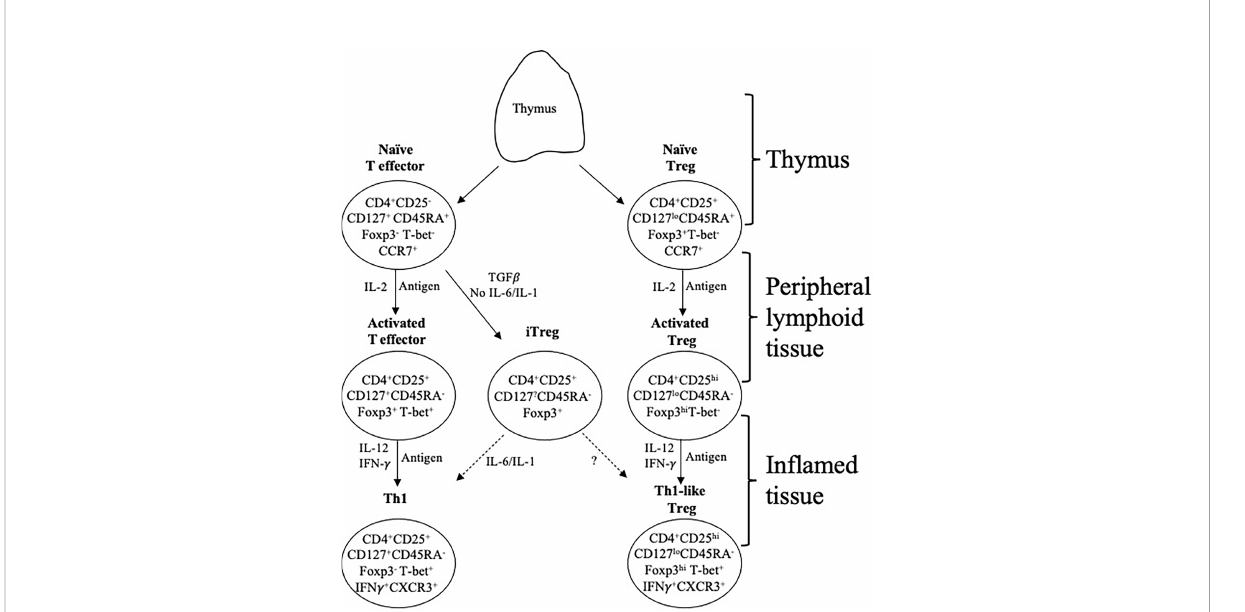
FIGURE 1 Effector lineage CD4 + CD25 - CD127 + CD45RA + Foxp3 - and Treg. CD4 + CD25 + CD127 lo CD45RA + Foxp3 + T cells are concurrently produced in the thymus and migrate from there to peripheral lymphoid tissue. They recirculate from lymphoid tissue to blood and back to lymphoid tissue, which is promoted by expression of CD62L and CCR7. When they recognize an antigen, they are activated and proliferate. In this process the effector lineage cells produce IL-2 and express IL-2R including CD25 (IL-2R a chain). The IL-2 activates CD25 both on Treg and effector cells. In an immune response, naïve T cells (CD4 + CD25 + CD127 + CD45RA + Foxp3 - T-bet - CCR7 + ), in the presence of IL-2 and antigen, acquire CD25, Foxp3 and T-bet expression but no longer express CD45RA. This transient expression of Foxp3 and CD25 blurs the distinction between Treg and effector T cells. These effector CD4 + T cells produce IL-2 that promotes polyclonal expansion of tTreg. Activated T effector cells, in the presence of IL-2 and IFN- g , get further activated to express the transcription factor T-bet and acquire chemokine receptor CXCR3 and produce IFN- g . In parallel, in the presence of an antigen, IL-2 induces proliferation of resting tTreg that recognize the speci fi c-alloantigen. This activated antigen-speci fi c Treg population (CD4 + CD25 hi CD127 lo CD45RA - Foxp3 hi ) is induced to express the receptor for late Th1 cytokines IL-12 and IFN- g . Further, these activated cells, in the presence of IL-12 or IFN- g become Th1-like Treg, which express mRNA for Th1 transcription factor T-bet, Th1 cytokine IFN- g and Th1 chemokine receptor CXCR3. Th1-like Treg continue to suppress and have a much greater potency than resting/ naïve Treg. Because they are progeny of tTreg, they have demethylated TSDR and stable Foxp3 expression. These activated memory Treg control immune in fl ammation in the graft and promote tolerance. They are the mediators of transplant tolerance. In the presence of TGF b , but not IL-6 or IL-1, naïve T cells can become induced Treg (iTreg) expressing CD25 and Foxp3. These iTreg are unstable as their TSDR is not demethylated. In an in fl ammatory environment they can revert to activated effector T cells. Whether they can become stable activated/memory Treg is